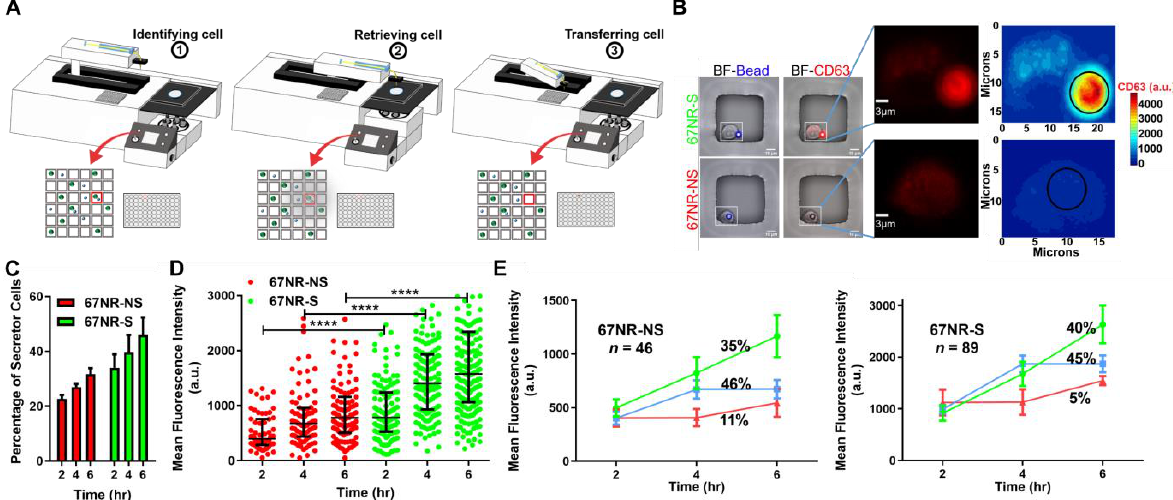
Figure 3. Establishment and validation of 67NR secretor (S) and non-secretor (NS) clonal cell lines. ( A ) Schematic of the overall workflow for the imaging and retrieval single cells secreting EVs with the aid of an automated micromanipulator. ( B ) Representative images of 67NR secretor and non-secretor single cells before retrieval. The insets show single cells and the contour map of CD63 (EVs) intensity. ( C ) Comparison of the frequency of cells secreting EVs within expanded populations of 67NR-NS and 67NR-S cells (mean ± SEM). ( D ) The rate of secretion of CD81 + CD63 + EVs by cells within the 67NR-S population is higher than the rate of secretion by cells within the 67NR-NS population at two, four, and six hours. Each dot represents a single cell with the median and quartiles of CD63 (EVs) intensity shown in all cells. A single representative experiment from four independent repeats is shown. **** p < 0.00001. ( E ) The kinetics of EV secretion from individual cells that comprise the 67NR-NS and 67NR-S populations. The three subpopulations corresponding to (1) continuous secretion (green), (2) secretion initiated at two hours (blue), and (3) delayed secretion at four hours (red) are shown as trend lines (mean ±